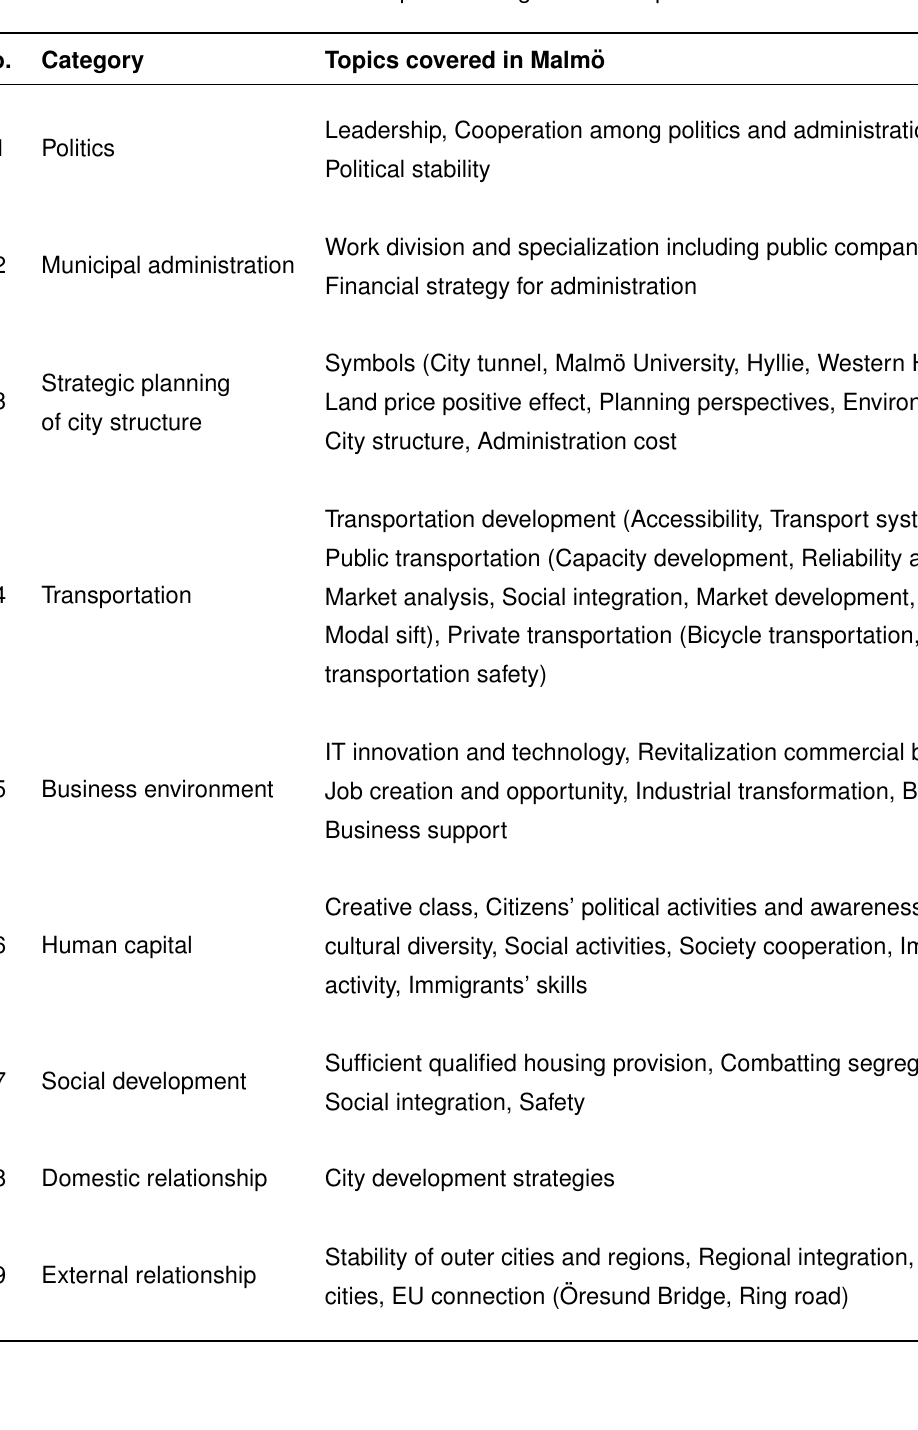
Table 4. Context-specific categories and topics covered in